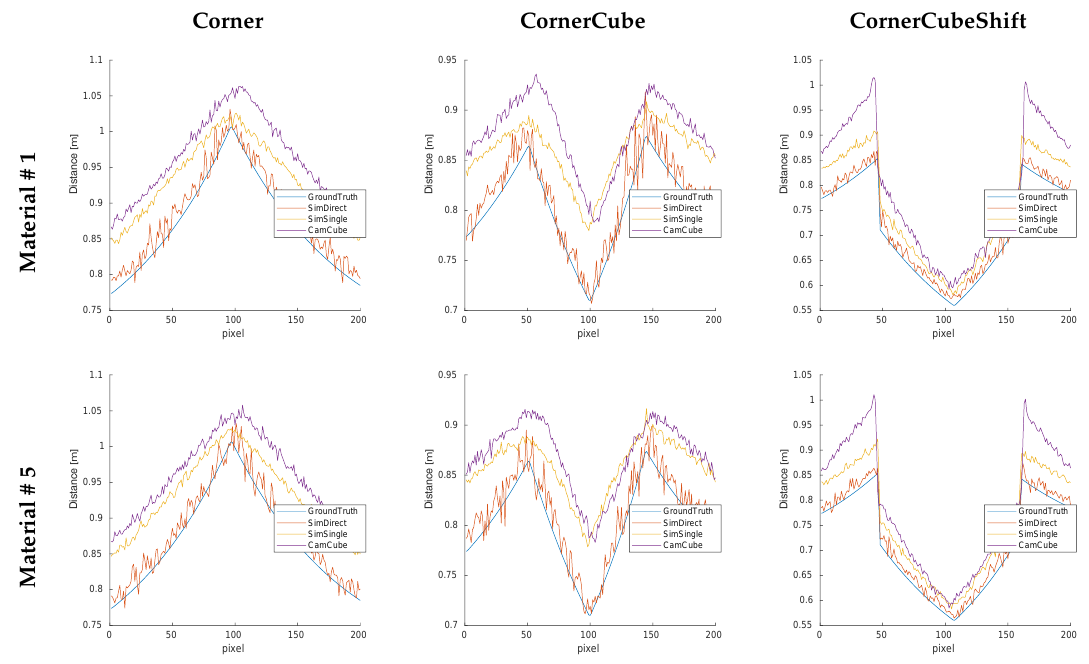
Figure 8. Range comparison for scanlines 100 for the three test scenes Corner (left), CornerCube (middle) and CornerCubeShift (right) for Material #1 & Material #5 .